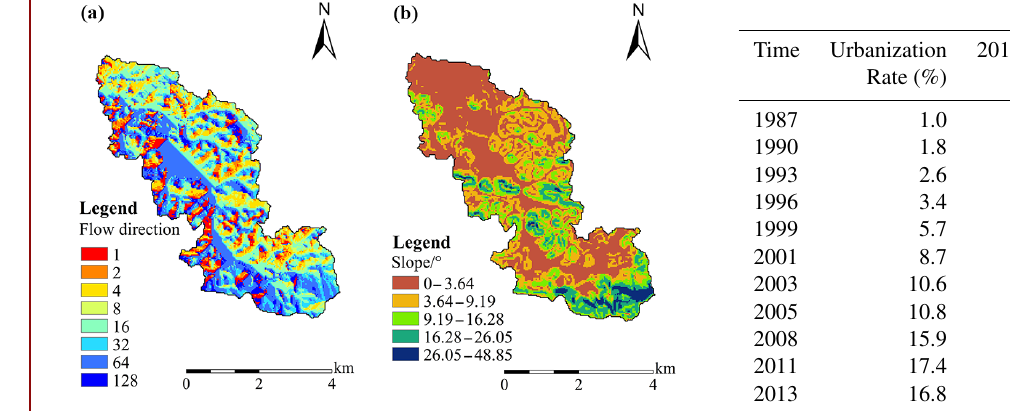
Figure 5. (a) Flow direction. (b) Slope. Topography-related model parameters.